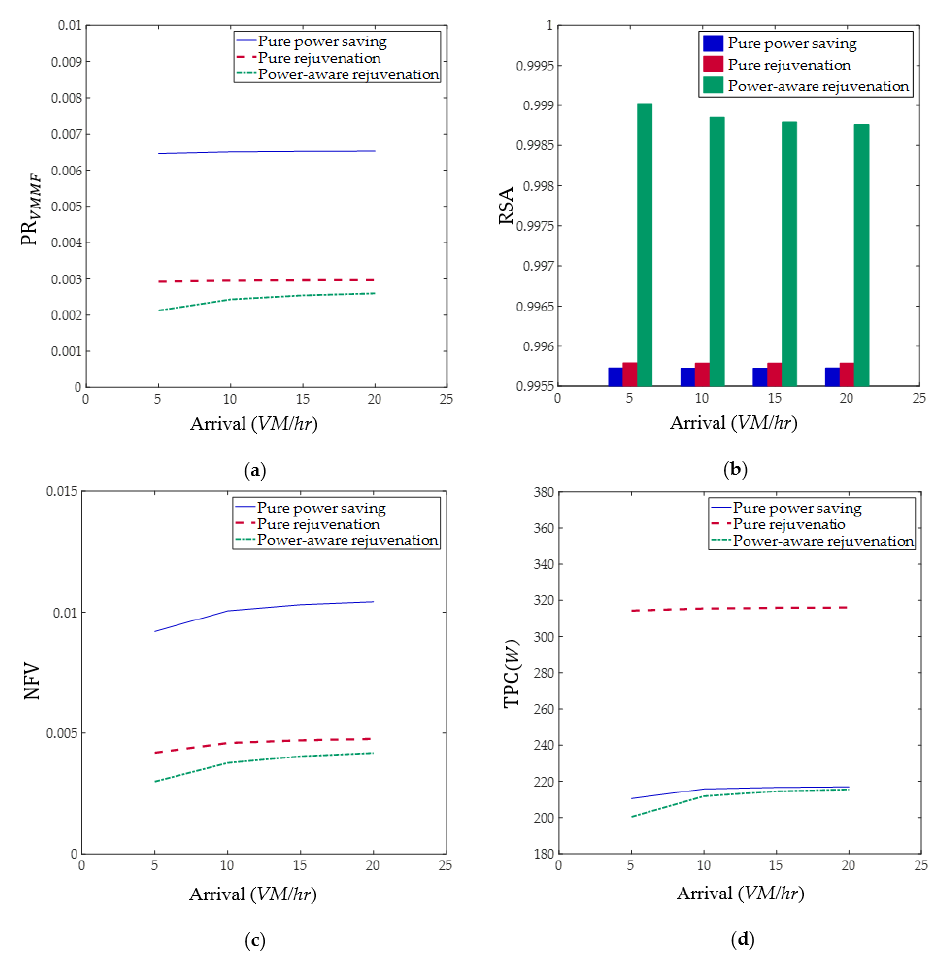
Figure 3. Results obtained by solving the proposed SAN model representing ( a ) probability of VMM failure, ( b ) ratio of serving VMs to accepted VMs, ( c ) mean number of failed VMs and ( d ) total power consumption.